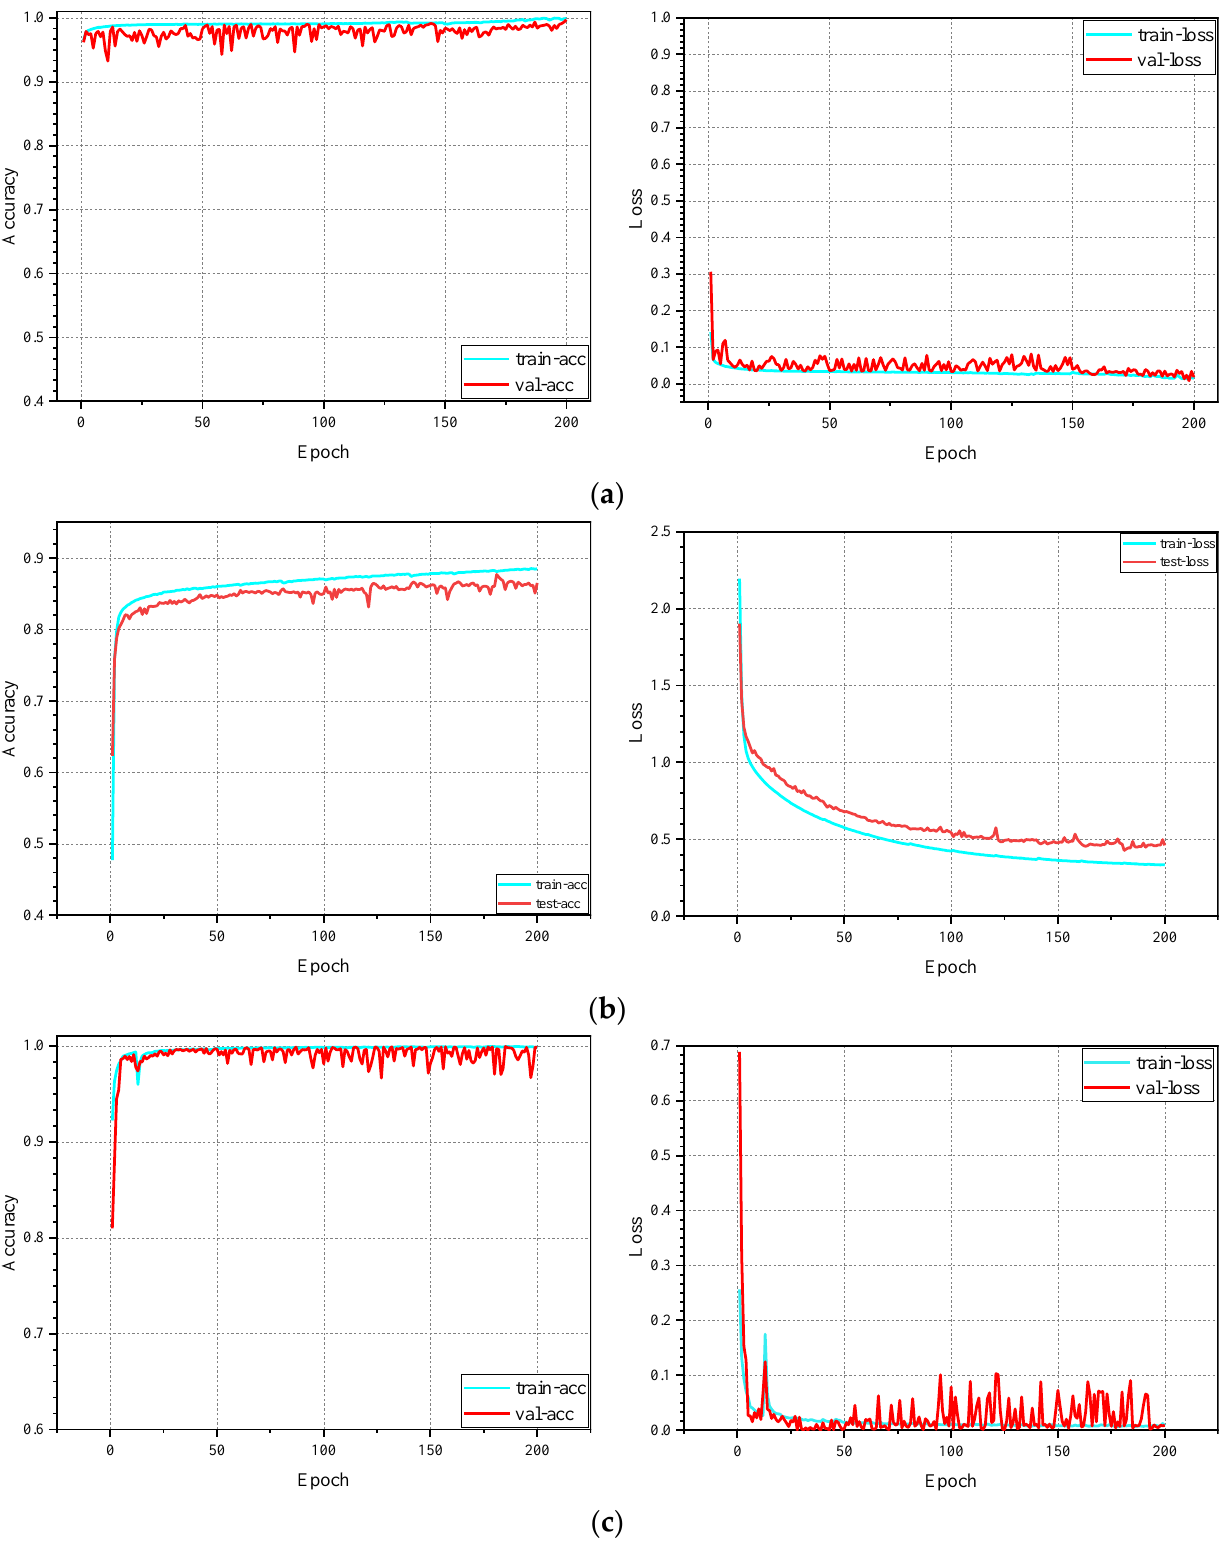
Figure 10. Accuracy and loss value curves with iteration steps: ( a ) Accuracy, loss value with the number of iteration steps curve of the NSL-KDD dataset; ( b ) Accuracy, loss value with the number of iteration steps curve of the UNSW_NB15 dataset; ( c ) Accuracy, loss value with the number of iteration steps curve of the CIC-IDS2017 dataset.